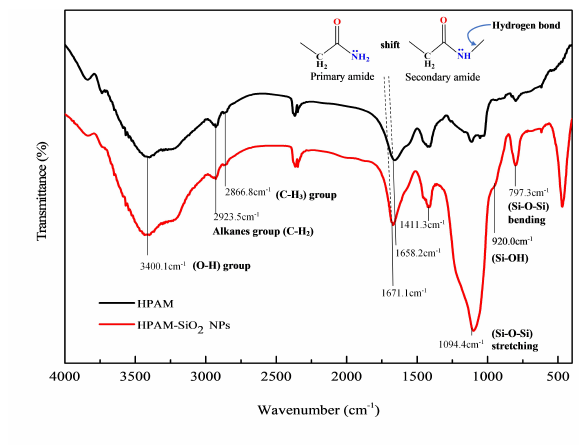
Fig. 2. FT-IR spectra of HPAM and HPAM-SiO 2